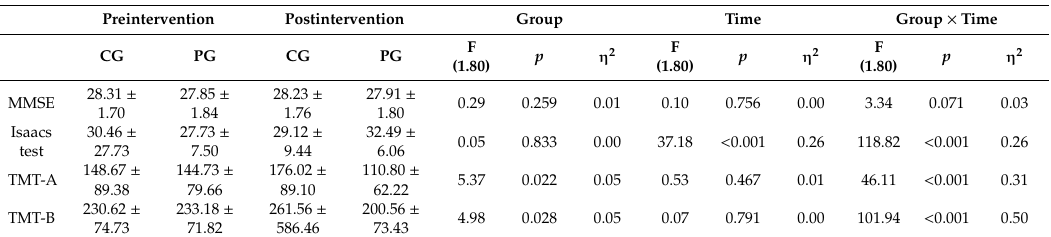
Table 2. E ff ects of Pilates training on global cognitive function, verbal fluency, and motor and visual